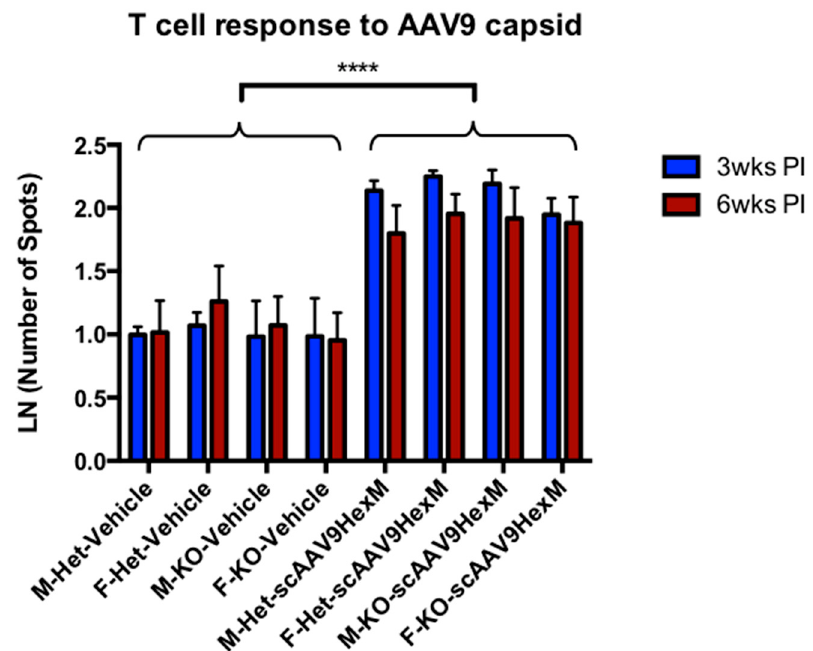
Figure 3. ELISpot IFN- γ secretion in response to AAV9 capsid peptides in male and female Het and KO TSD mice 3 weeks and 6 weeks post vehicle or scAAV9- HEXM injection (PI). Mice receiving scAAV9- HEXM showed significantly higher number of spots to AAV9 capsid peptides compared to vehicle-injected mice (ANOVA main effect of treatment, p < 0.0001). Differences between males versus females and Het versus KO mice were not statistically significant. A post hoc analysis found that among scAAV9- HEXM -treated mice, the T cell response in splenocytes harvested from mice at 6 weeks was less than that in splenocytes harvested from mice at 3 weeks (blue versus red bars, right half of graph, p < 0.01). M = male, F = female, wks = weeks, PI = post injection. Error bars = SEM, N per grou p = 3, **** = p < 0001.